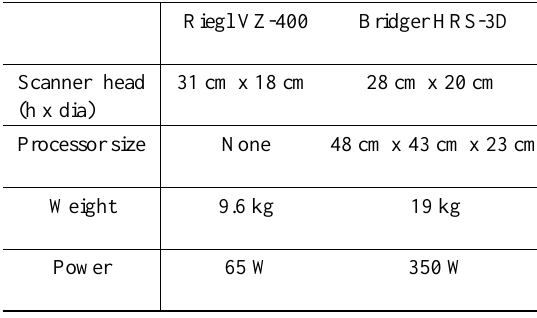
Table 1: Size, weight, and power comparisons of the two